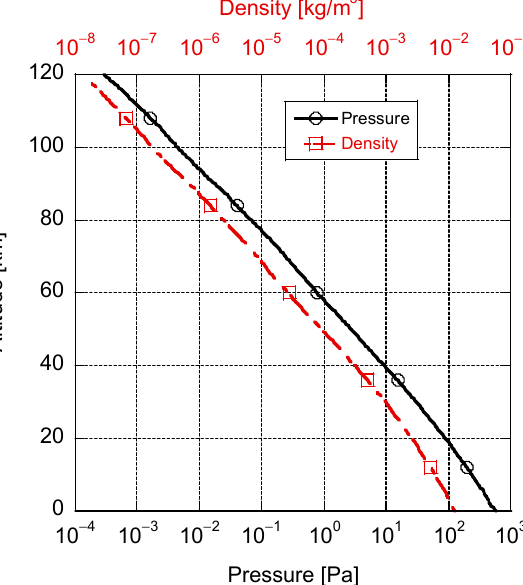
Figure 2. Martian atmospheric pressure and density with respect to altitude, adapted from [17].